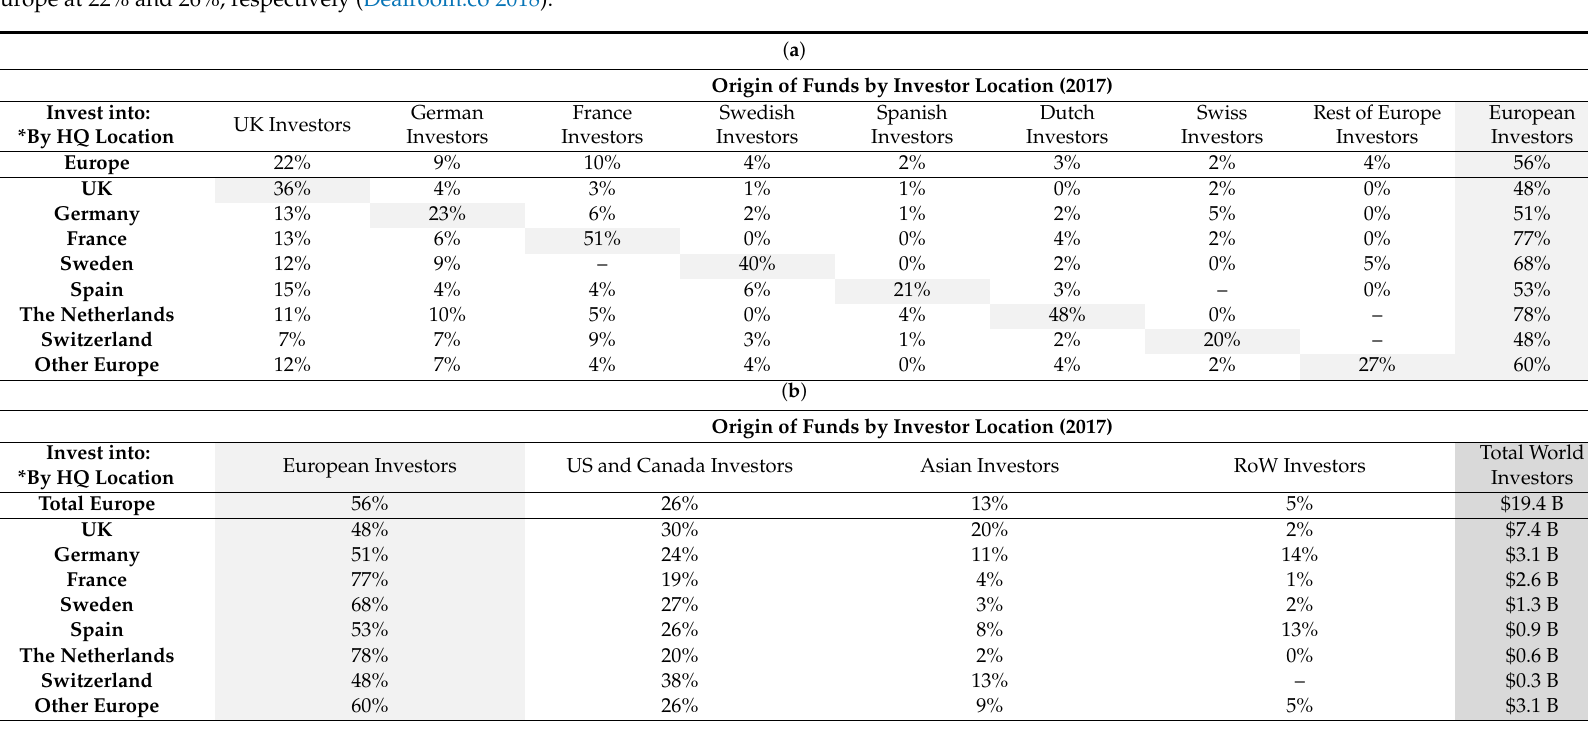
Table 2. ( a ) Percentage of VC amount contributed by investor and investee location (2017) (Dealroom.co 2018). Fifty-six percent of the total amount received by European companies comes from European VC funds, or $10.9B, into European companies. UK investors contribute 22% of total VC amount received by European companies. The UK invests more capital outside its own country than any other country in Europe. Together, the UK and US are responsible for almost half of all capital invested into Europe at 22% and 26%, respectively (Dealroom.co 2018). ( b ) Together, the UK and US are responsible for almost half of all capital invested into Europe at 22% and 26%, respectively (Dealroom.co